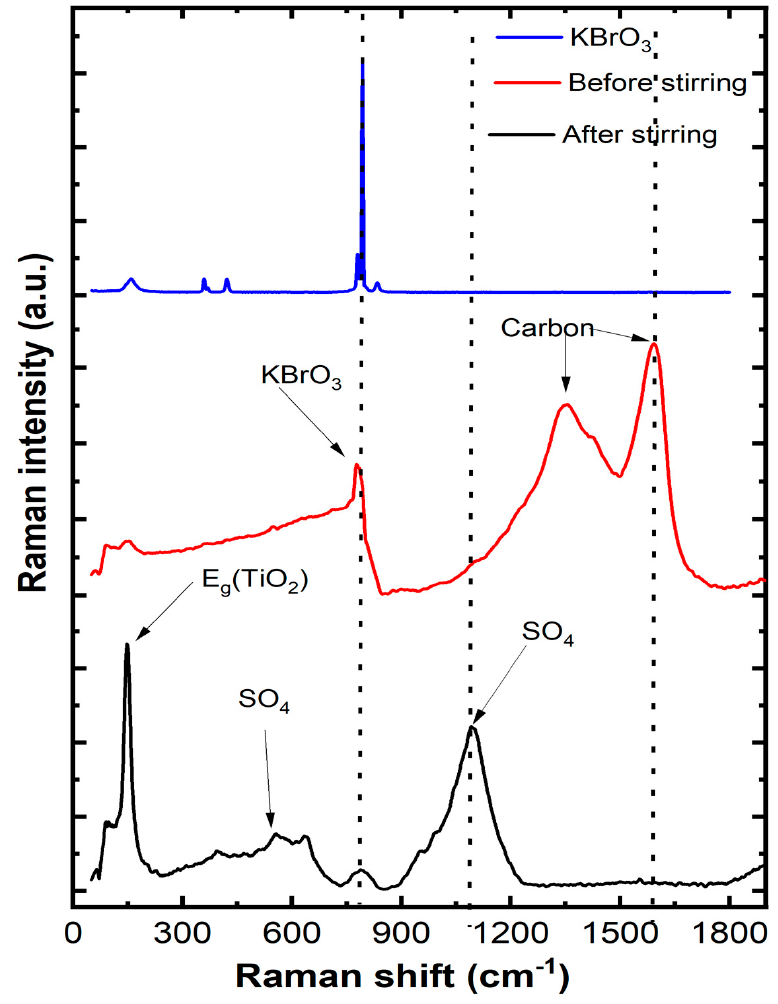
Figure 11. Raman spectra of KBrO 3 , and final products of TiO 2 /5 mg-KBrO 3 in PR solution irradiated for 110 min. Note: The samples were withdrawn from the final solution before and after stirring.